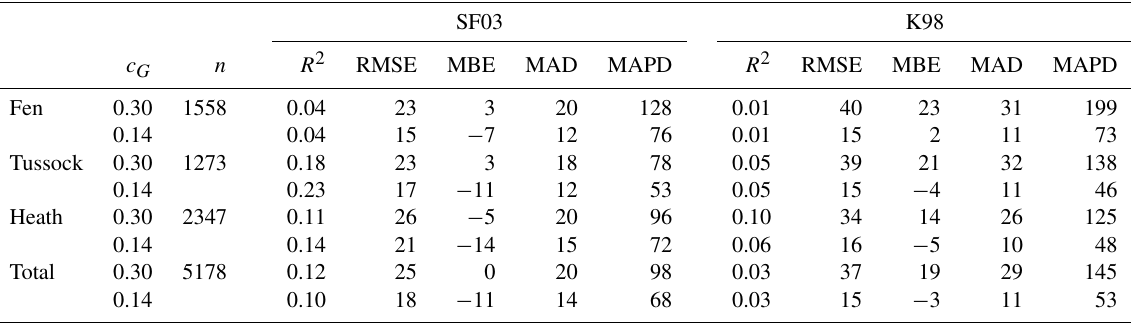
Table 3. Performance statistics for the soil heat flux estimation using Santanello and Friedl (2003) (SF03) and Kustas et al. (1998) (K98) methodologies and two values for the maximum c G value. RMSE, MBE and MAD are in Wm − 2 and MAPD is in %.